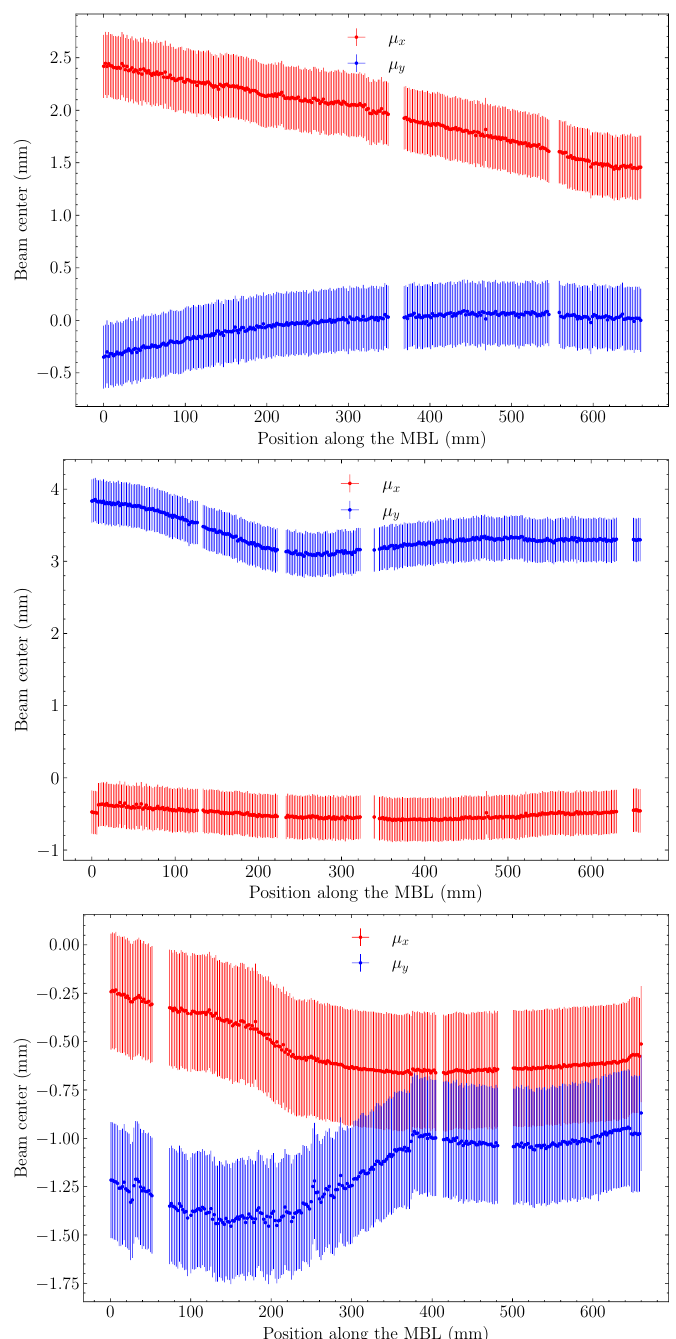
Figure 7. Measured position of the beam centroid in both horizontal (red) and vertical (blue) planes, along the MBL for the three different cases: MBL magnets off ( top ); a focused beam entering the MBL with magnets on ( center ); a flat beam entering the MBL ( bottom